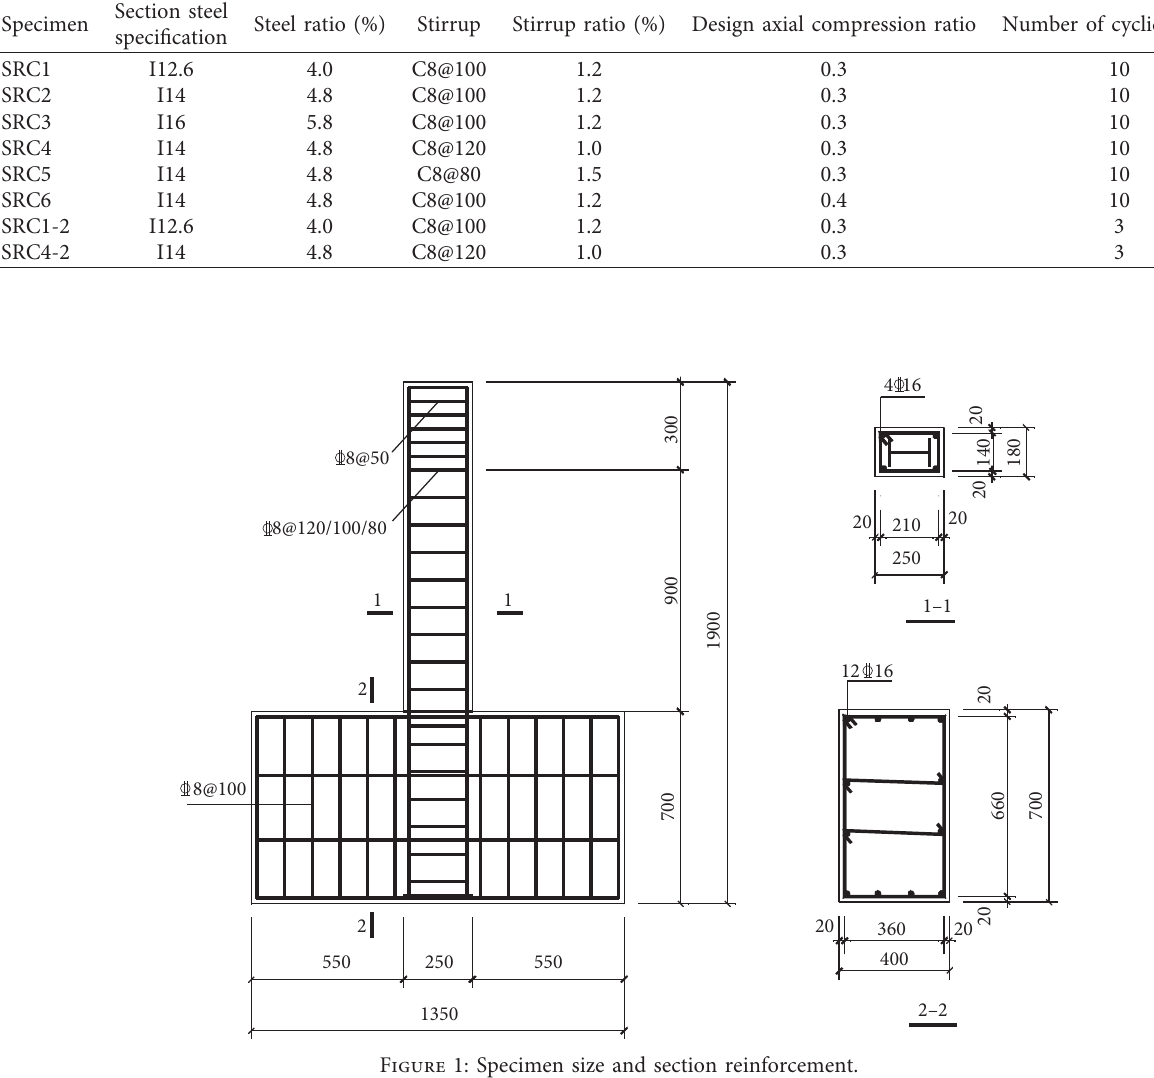
Table 1: Design parameters of specimens.